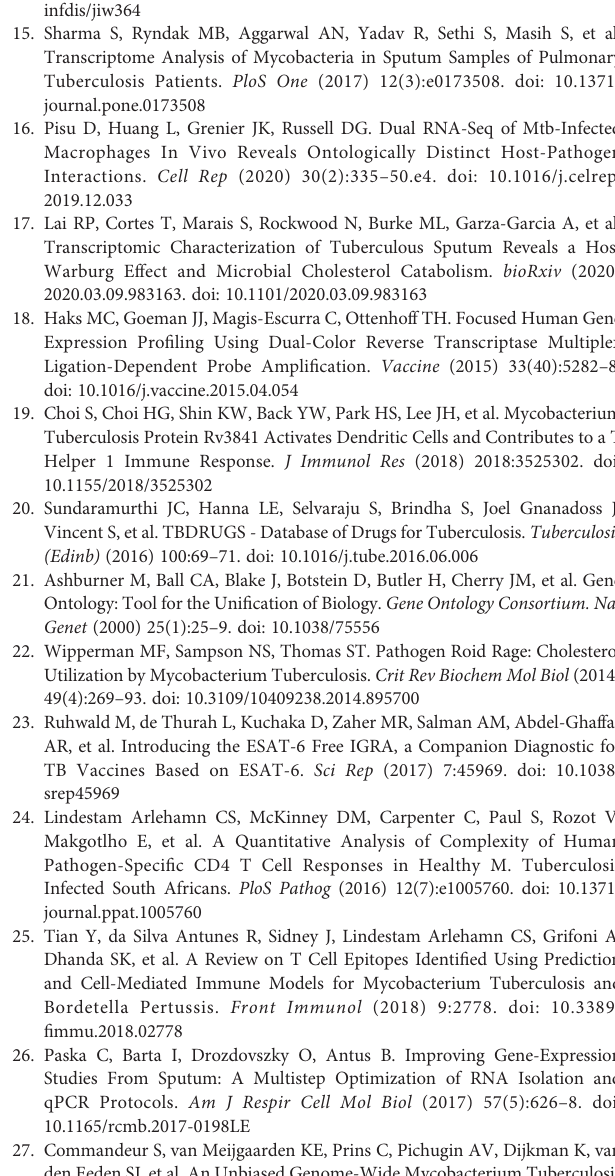
Supplementary Figure 1 | Expression level of Mtb genes belonging to speci fi c categories previously de fi ned in literature. Each heatmap lists Mtb genes belonging to previously de fi ned functional categories (11, 22). Speci fi c pathways are indicated on the right of the genes encoding proteins related to metabolic pathways. Each column represents the relative expression rank within each dataset. Datasets are listed from left to right with the following order: C3HeB/FeJ mouse lung dataset (8) (A) ; human sputum (HS) dataset from Ugandan TB patients (10) (B) ; HS (C1) and BAL (C2) from a cohort of South African TB patients (12); a microarray (MA) based dataset (D) from sputa of Indian TB patients (15). Red color coded Rvs indicate Mtb genes of the mega-pool which overlap with Figure 3B . Supplementary Table 1 | Source Data. This fi le contains nine supplementary tables for this paper. Tables S1.1 – S1.7 report the normalized data available for each of the published dataset. These datasets describe the expression of Mtb genesin:lungofinfectedC3HeB/FeJ (C3H)(S1.1) (8);alveolarmacrophages (AM)of